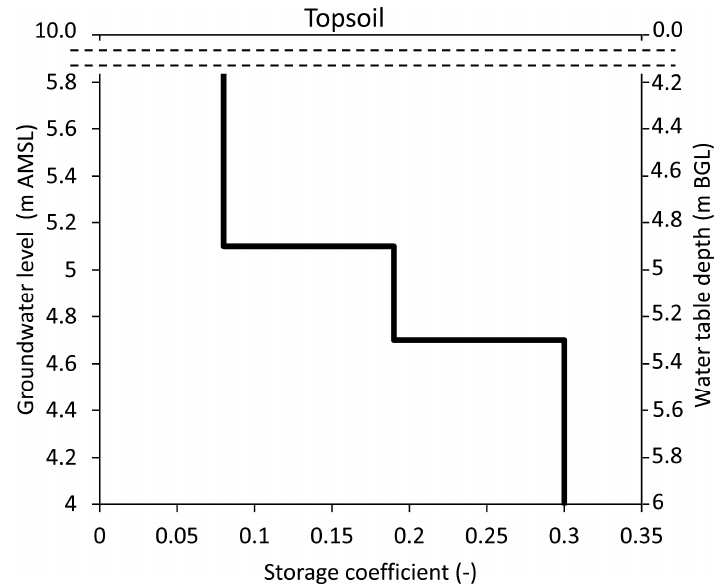
Figure 8. Estimated step function of the storage coefficient as a function of the water table depth determined by means of the minimization between the observed and simulated groundwater level. Water 2020 , 12 , x FOR PEER REVIEW 14 of 21